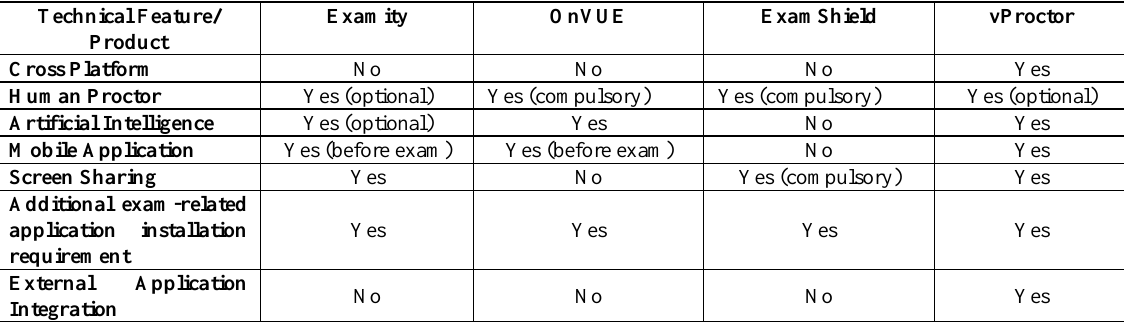
Table 1 . Comparison of similar products on distance